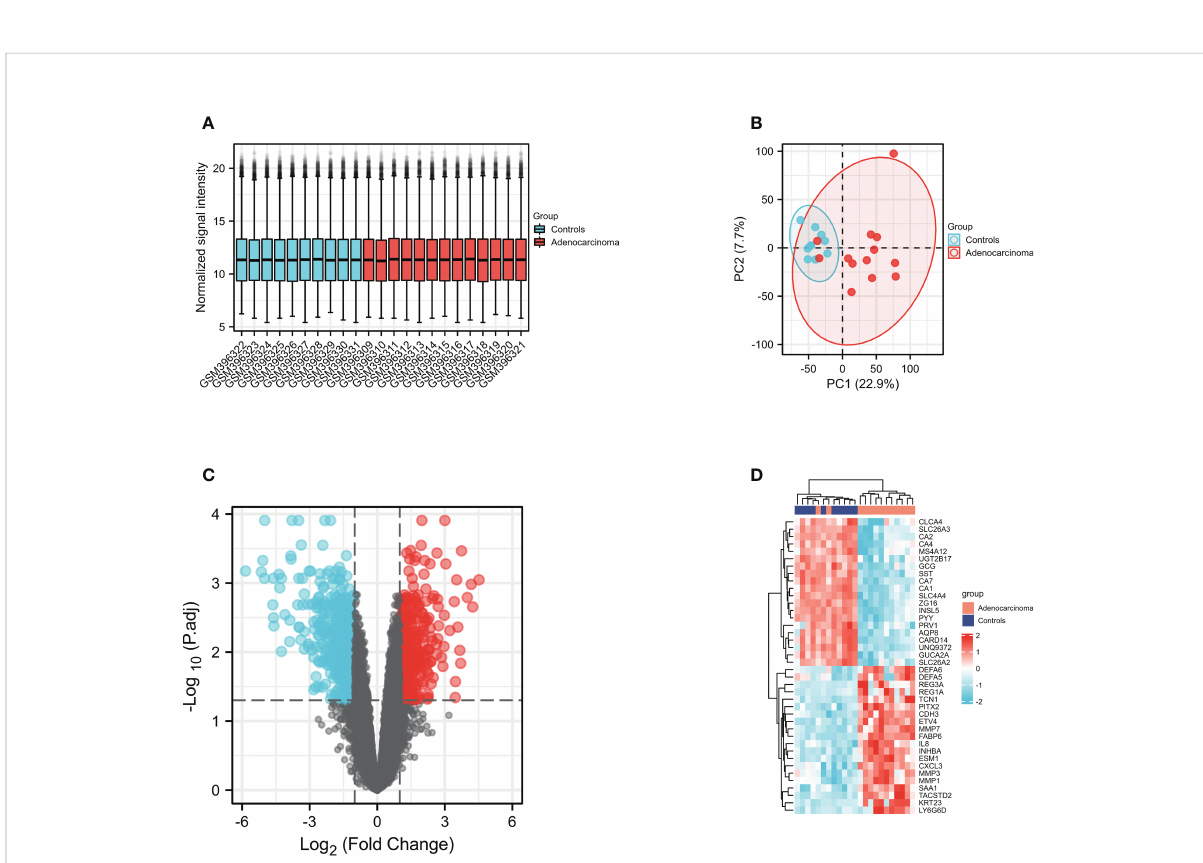
FIGURE 4 Gene expression pro fi les of COAD. (A) Normalized bar plot of the GSE715781 dataset; (B) PCA analysis of the GSE15781 dataset; (C) Vocanol plot of the GSE15781 dataset. Gene expression analysis of the GSE15781 dataset; (D) Heatmap of the top 40 genes in GSE15781 dataset.